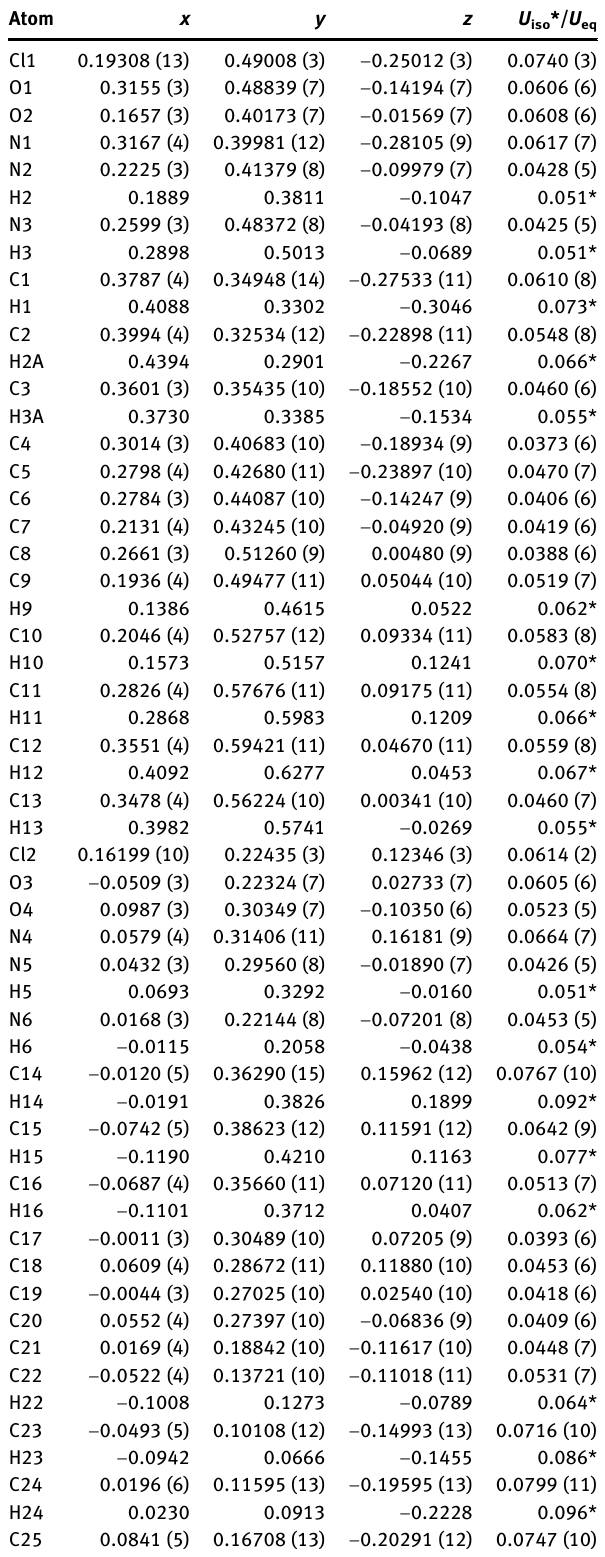
Table  : Fractional atomic coordinates and isotropic or equivalent isotropic displacement parameters (Å 